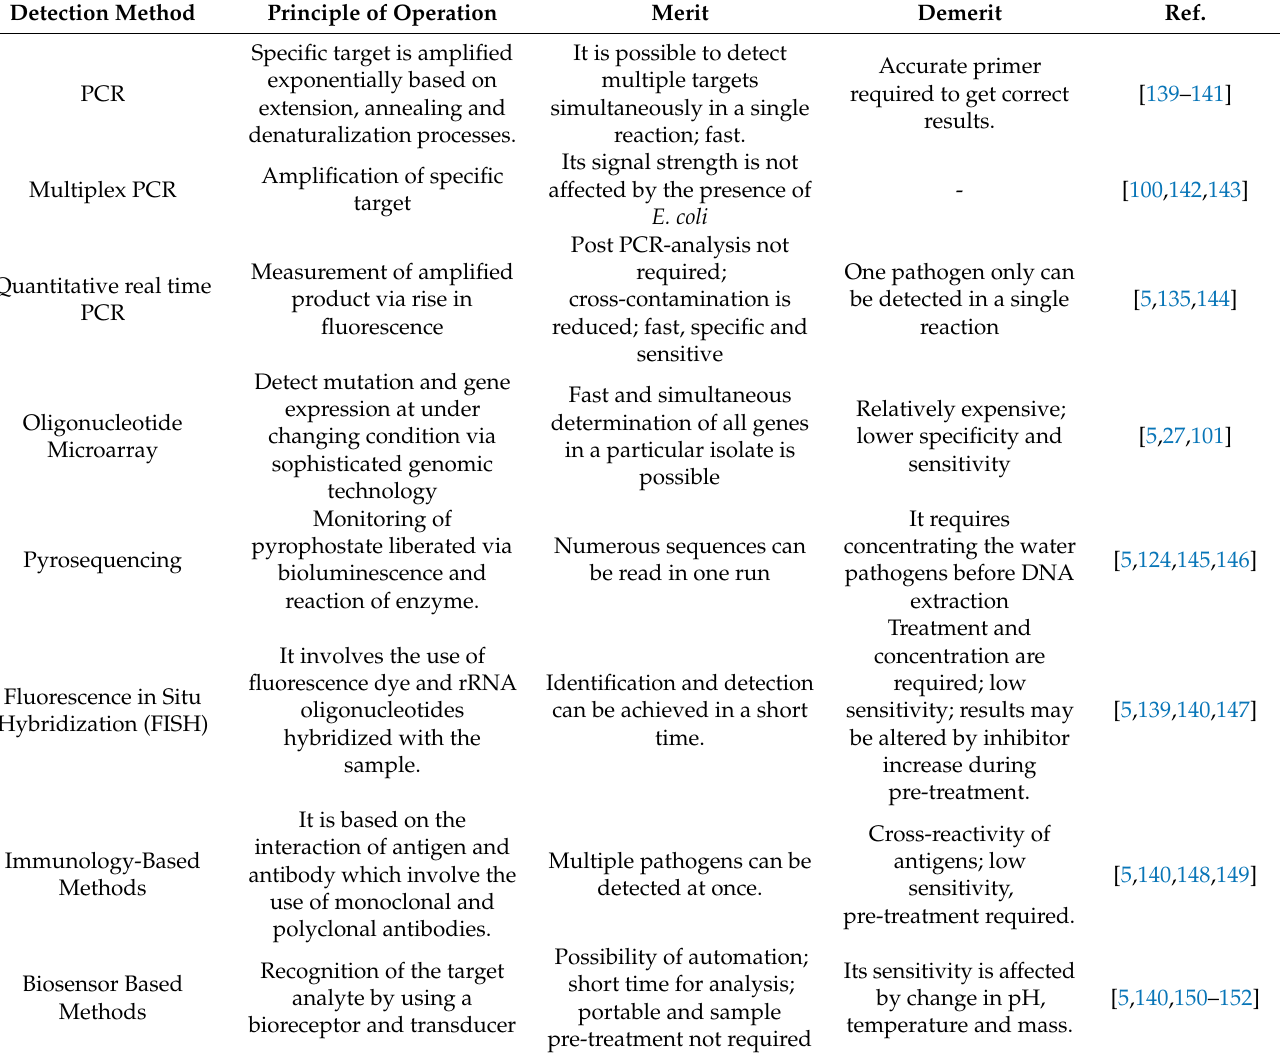
Table 2. Methods for detecting E. coli , their principle of operation, merits and demerits. Detection